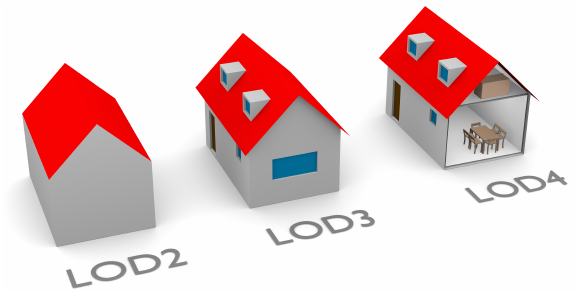
Figure 1: A building modelled in multiple LODs. The LOD labels are according to the categorisation of CityGML 2.0, and they denote both the granularity of the geometry and